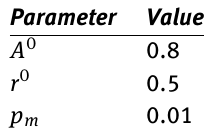
Table 1: Simulation parameters for BA and MBA